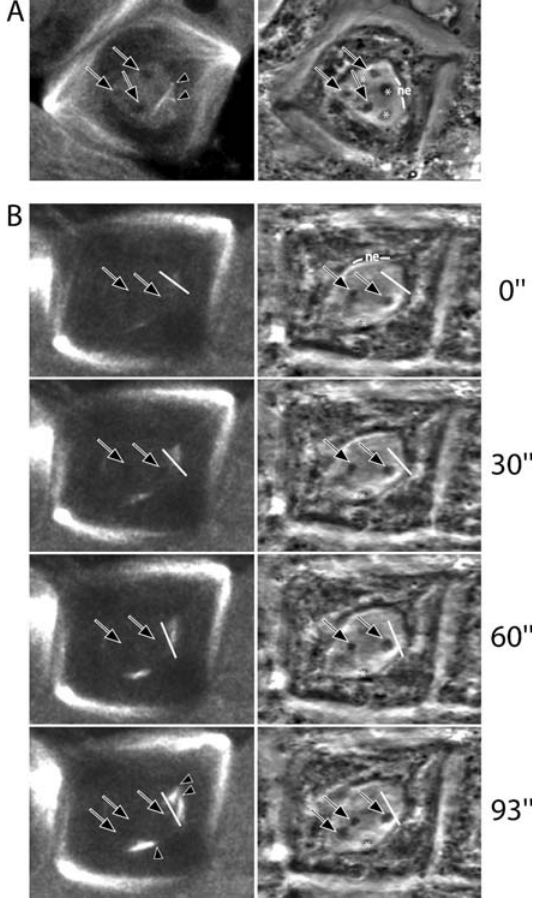
Figure 4. The Place of Noncentrosomal Microtubule Nucleation The initial stages of noncentrosomal microtubule nucleation revealed by an endogenous GFP– a -tubulin fusion (left) and phase contrast (right). Following the corresponding videos, it is possible to unmistakably tell the chromosomes (arrows) apart form the other phase-dark objects that are present over the nuclear region (asterisks). The cell in (A) is shown as a single timeframe and the cell in (B) as a time-lapse series. In both cells, noncentrosomal microtubule nucleation (arrowheads) takes place close to the remains on the NE and does not overlap with the major chromosomes. Nucleation sites can be clustered (A) or dispersed (B). In the time- lapse series (B), only the chromosomes that are in focus are labelled. Timepoint 0 min in these series corresponds to the first sign of noncentrosomal microtubule nucleation, around 11 min after NEB. A white bar marks the growing end of a microtubule bundle that at timepoint 93 min reaches one of the bivalents. DOI: